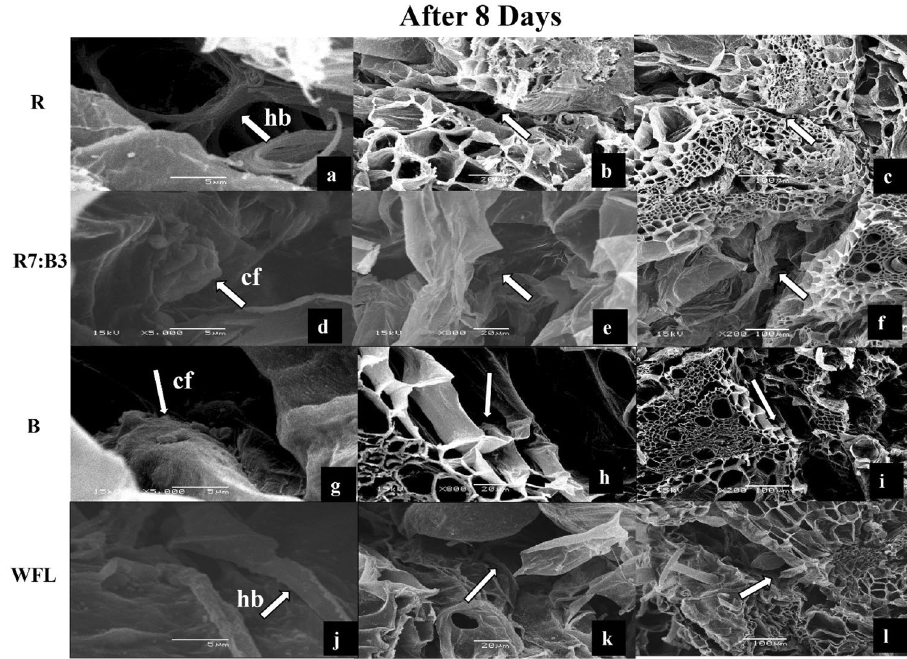
Figure 4. SEM images of interconnections between rootstock and scion after 8 days under R light ( a – c ), R7:B3 light ( d – f ), B light ( g – i ), and WFL light ( j – l ) light at the 8th days after grafting. fs—filamentous structures; hb— horizontal bridge; cf — formation of callus